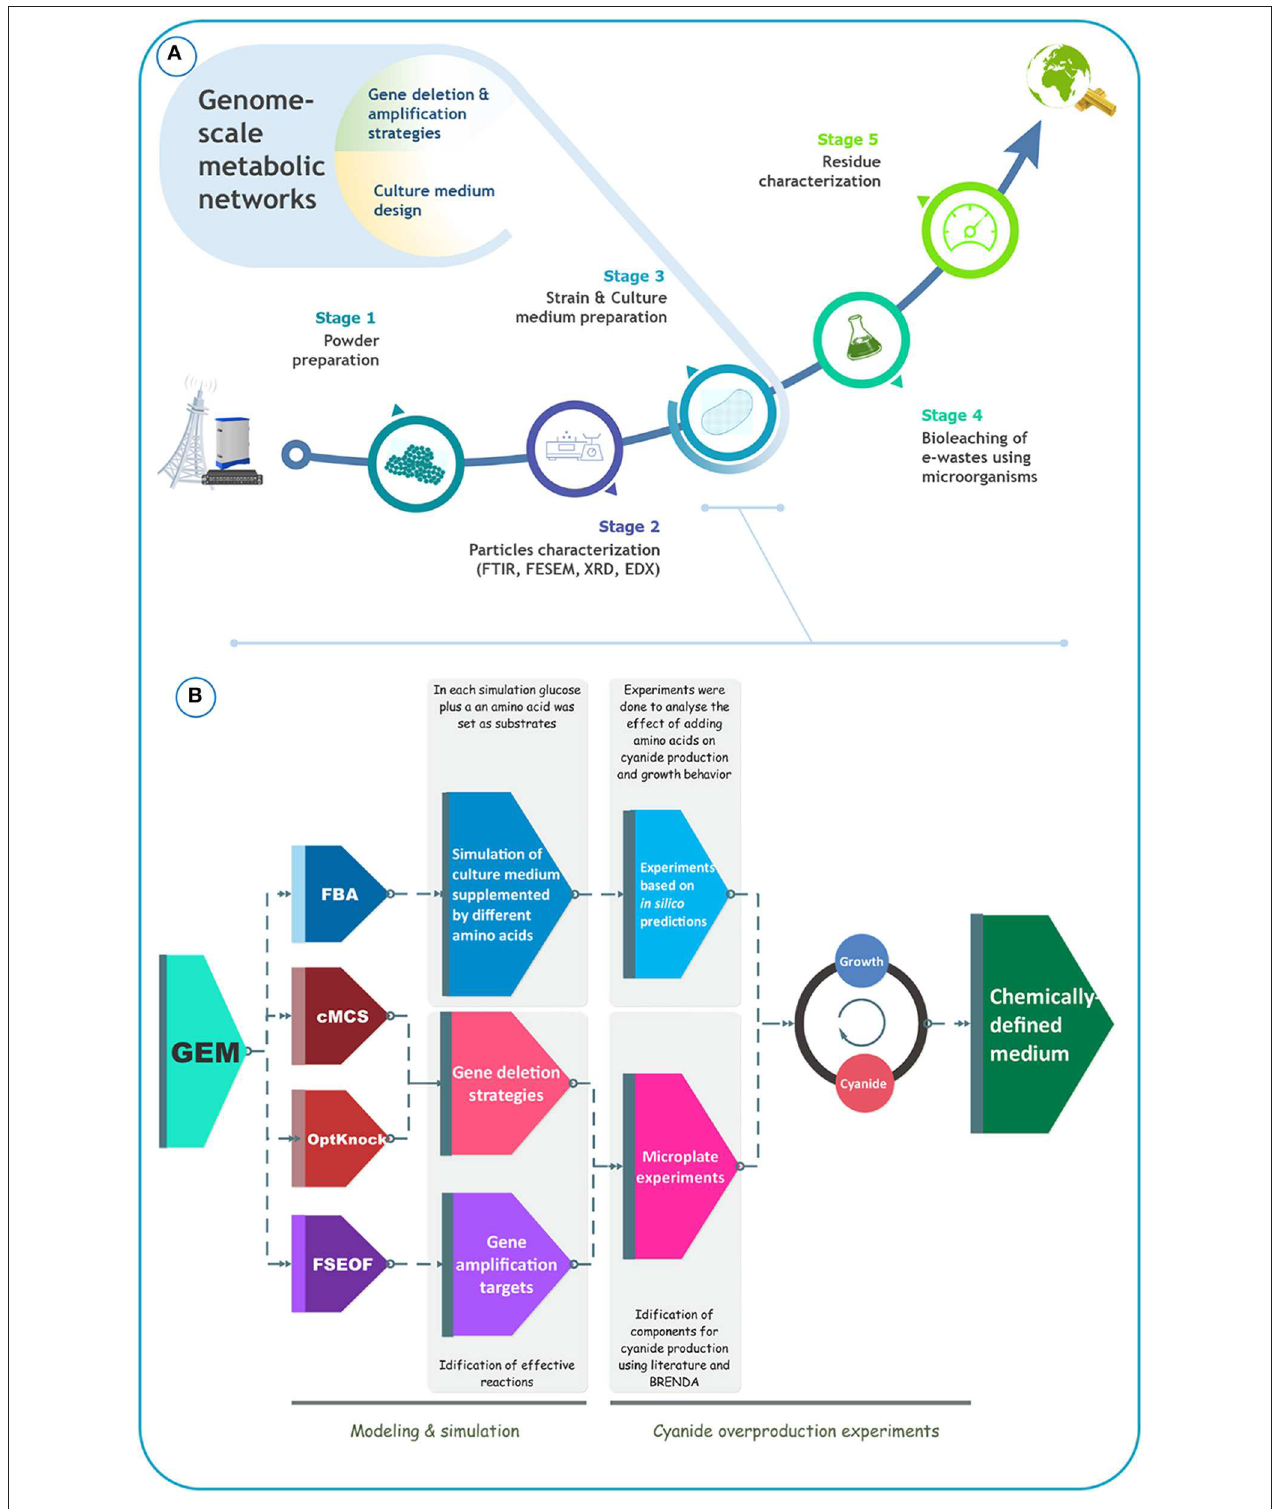
FIGURE 1 | (A) Schematical representation of the bioleaching process, (B) schematical representation of the procedure that was used to improve cyanide production by B. megaterium DSM319.